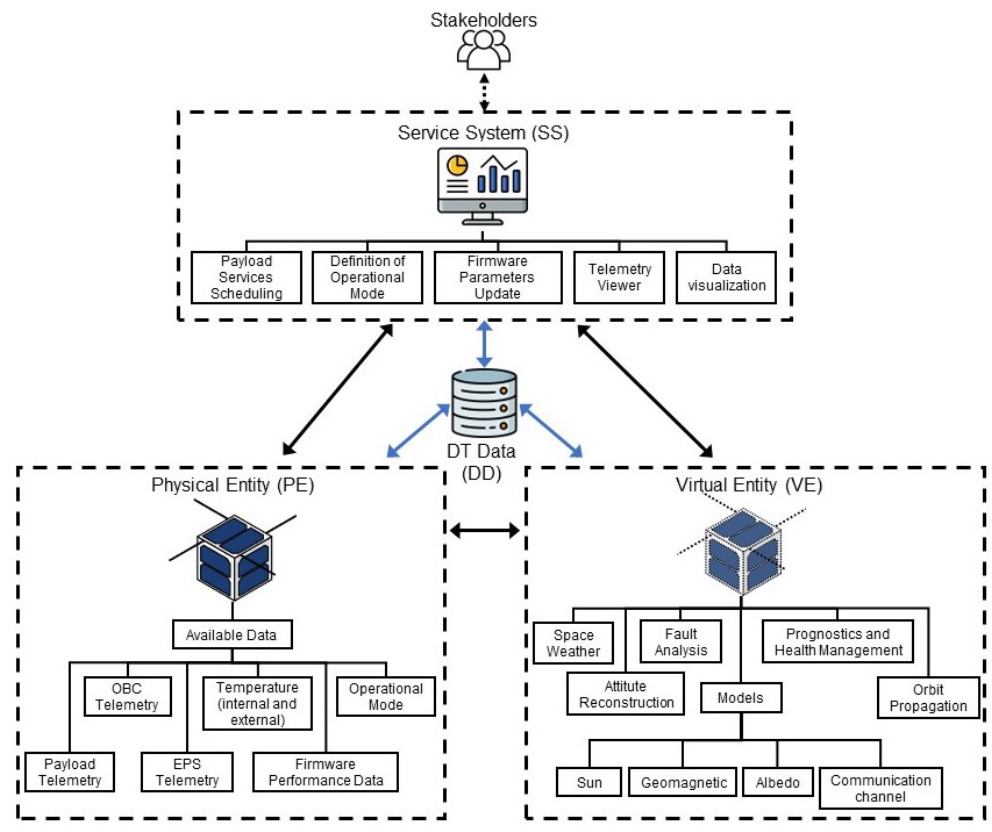
Figure 7. Five-dimensional architecture for the CubeSat digital twin